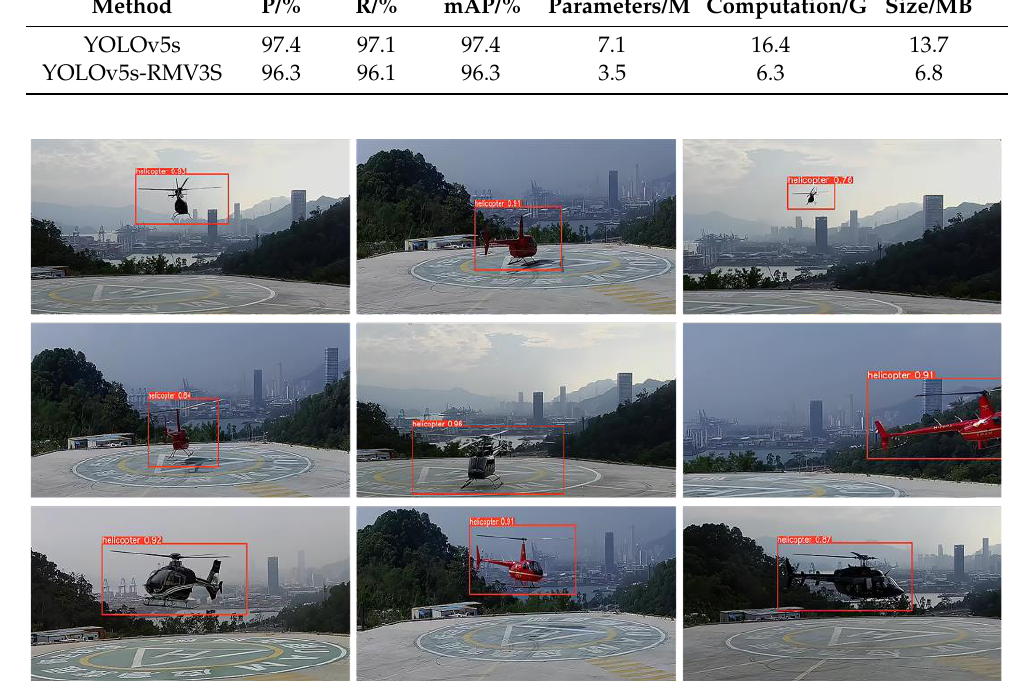
Table 2. Comparison of the performance of different thresholds for positive and negative sample selection.